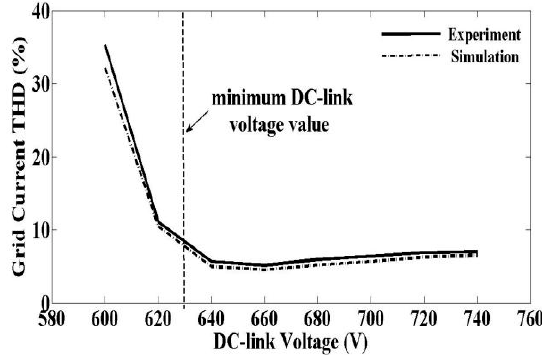
Figure 7. The grid current THD value with the variation of the DC-link voltage.